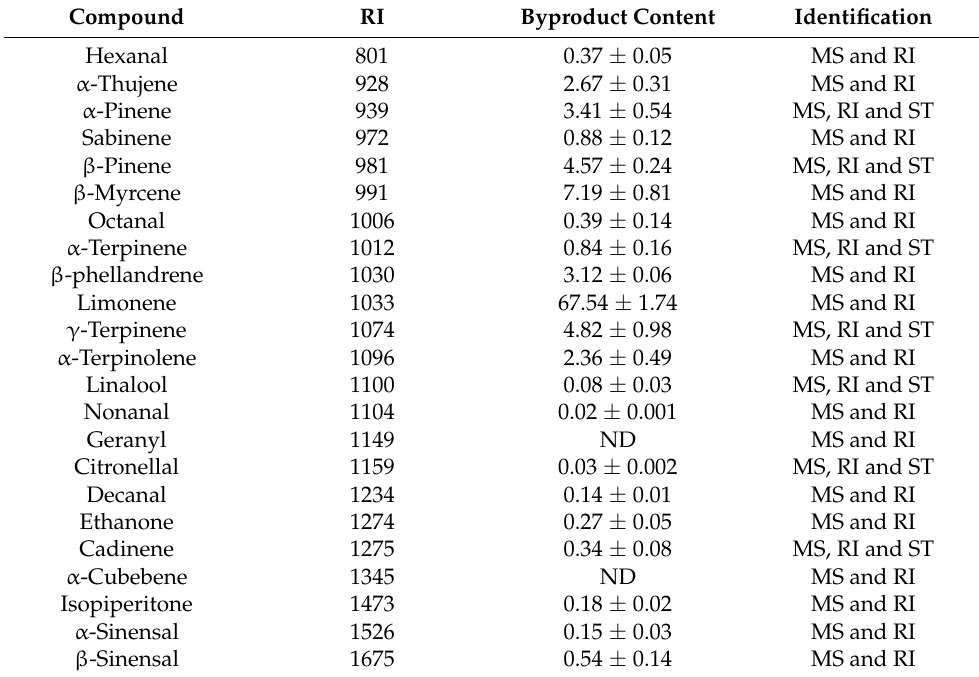
Table 1. Volatile compounds content determined in mandarin byproducts